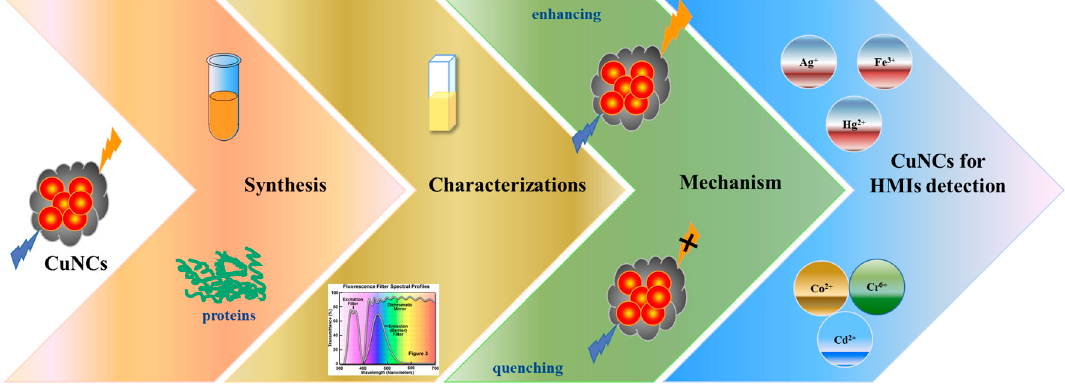
Figure 1. Summary of CuNCs and HMIs detection applications.